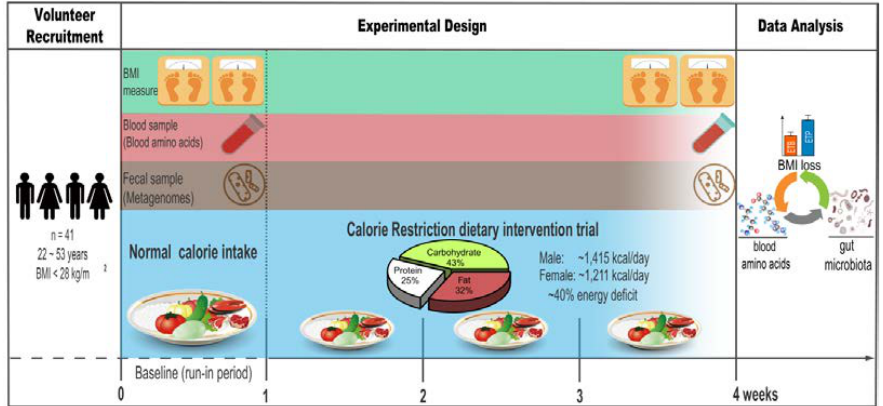
Figure 1. Overview of the experimental design. Illustration of our experimental design, including a 1-week run-in period (baseline) and a 3-week calorie restriction (CR) dietary intervention trial with approximately 40% energy deficit of the recommended daily calorie intake (men, ~1414.9 Kcal/day; women, ~1210.6 Kcal/day). Body Mass Index (BMI), fasting blood samples, and fecal samples of 41 enrolled healthy and non-obese subjects were collected before and after the intervention to assess the effects of CR on BMI, blood amino acids, and the gut microbiome.